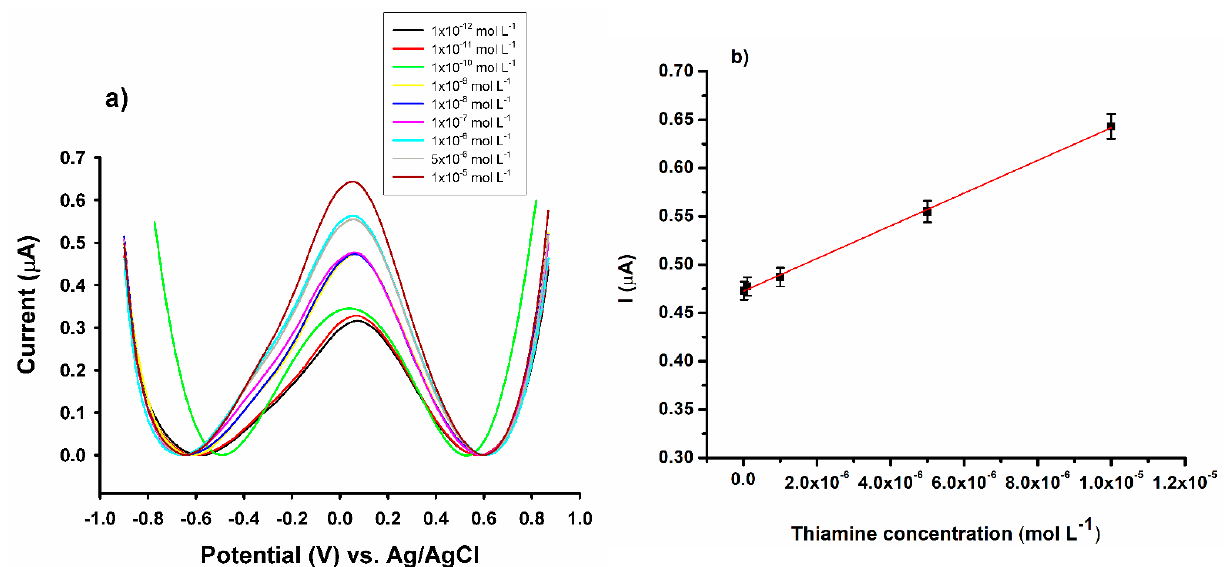
Figure 7. ( a ) Differential pulse voltammograms recorded with PIX/AuNPsnGr sensor in PBS pH 2.0 and 0.1 mol L -1 NaNO 3, containing different concentrations of thiamine from 1.0 × 10 -12 mol L -1 to 1.0 × 10 -5 mol L -1 . ( b ) Calibration curve obtained with PIX/AuNPsnGr sensor from 1.0 × 10 -12 mol L -1 to to 1.0 × 10 − 5 mol L − 1 . 1.0 × 10 -5 mol L − 1 . Working conditions: step potential 0.025 V, amplitude: 0.1 V.